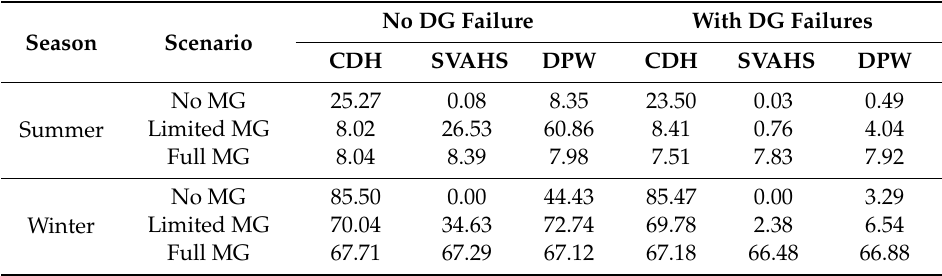
Table 11. Mean survival rates of the system with CDH PV in 14 days outages.